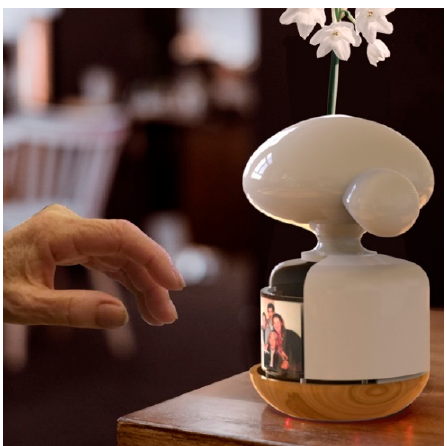
Figure 4. Interaction demonstration.